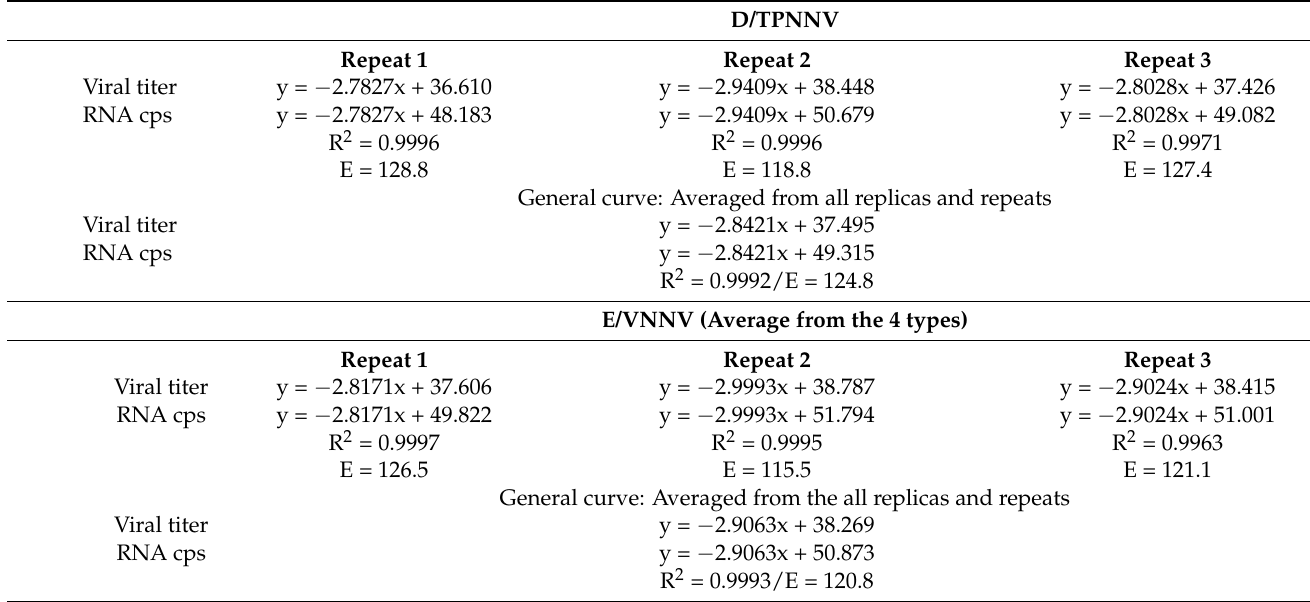
General curve: Averaged from the all replicas and